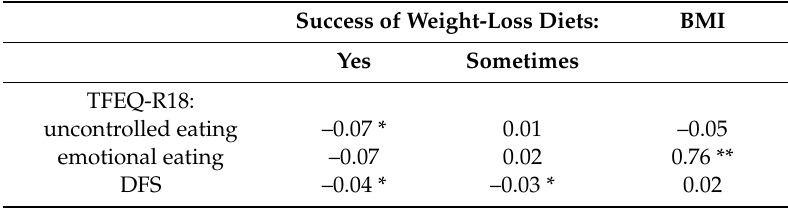
Table 4. Associations between eating behavior, body mass index (BMI), and success of weight-loss